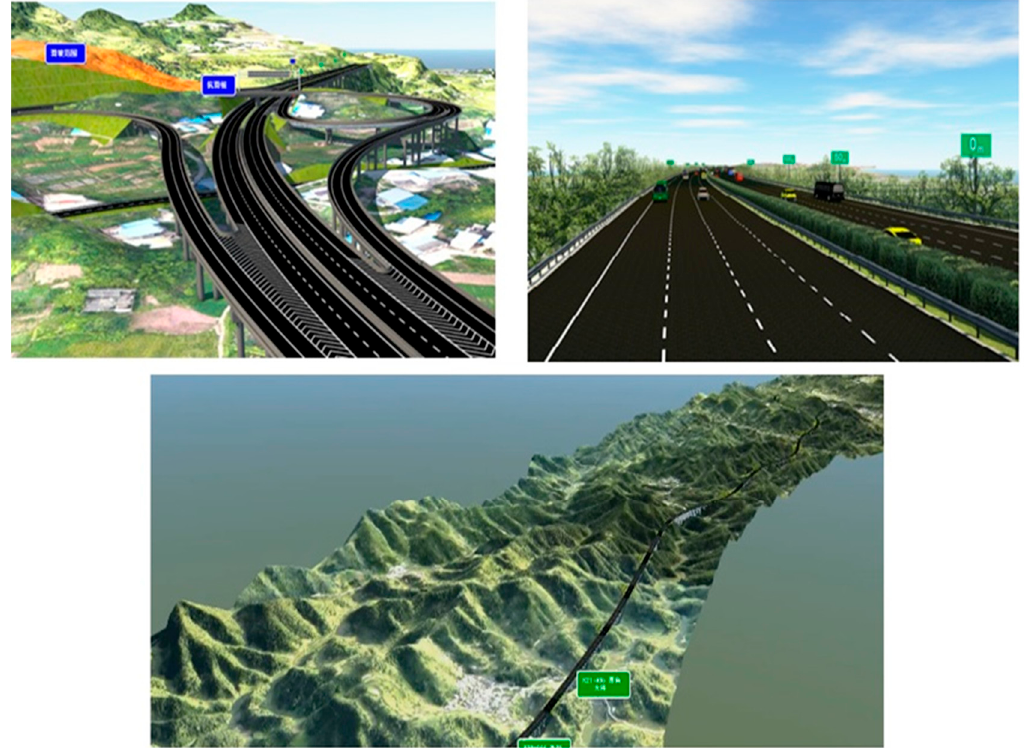
Figure 13. Optimized alignment for DuAn highway.